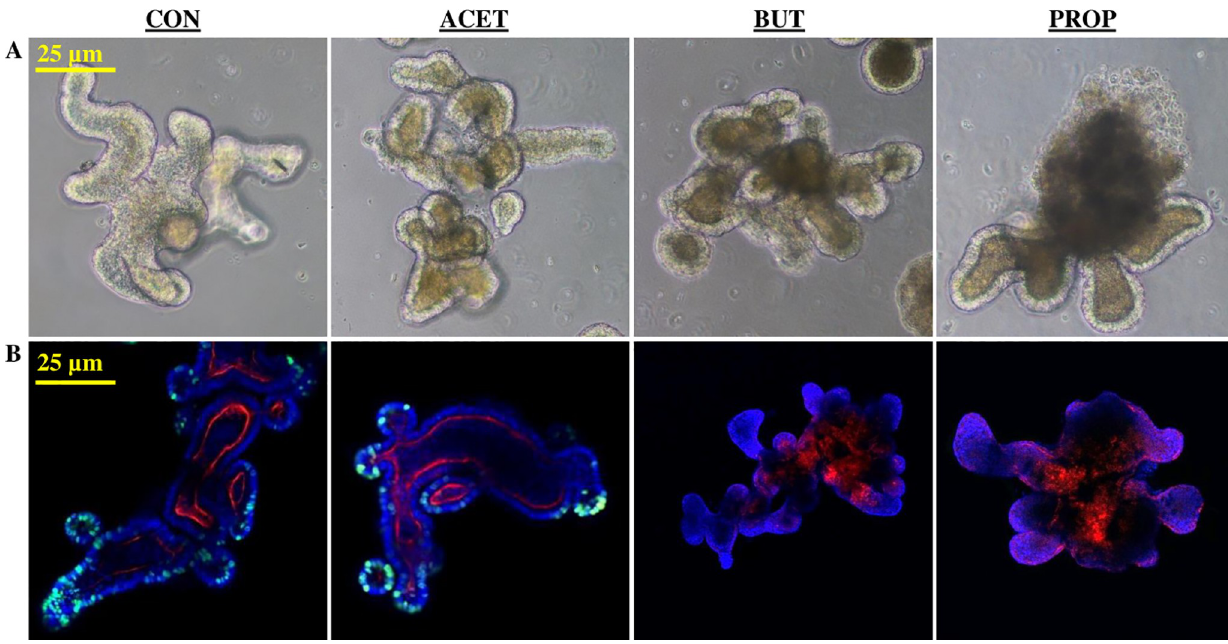
Fig 1. (A) Effect of 24 h treatment with 5 mM acetate (ACET), butyrate (BUT), or propionate (PROP) on morphology of 3D murine duodenal enteroids as well as (B) EdU cellular proliferation marker (green), and F-actin distribution (red) compared to controls (CON). Nuclei are stained in with DAPI (blue) and images are representative of several fields of view at 20X